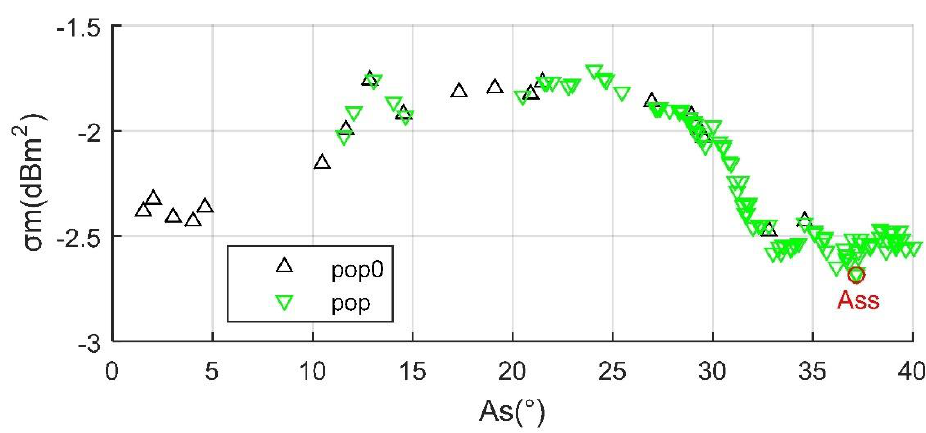
◦ , α ◦ , β = − 6 ◦ , and F m = 120 rv = 5